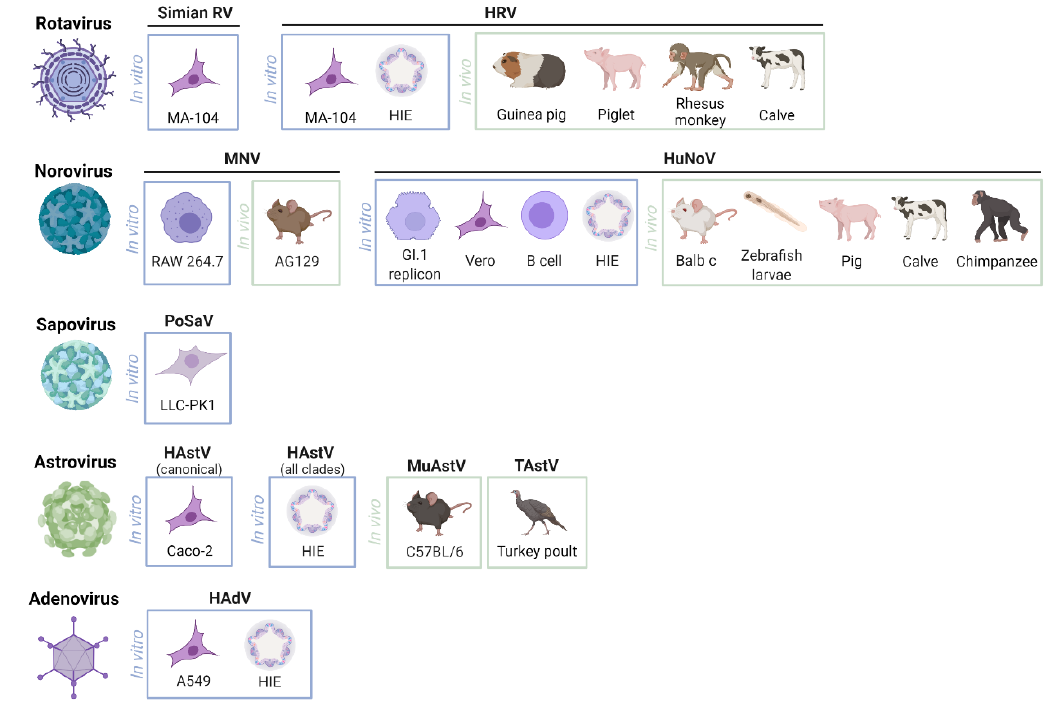
Figure 1. Most described in vitro and in vivo models to study human rotavirus, norovirus, sapovirus, astrovirus and enteric adenovirus, and their surrogates. RV—Rotavirus; HRV—Human rotavirus; HIE—Human intestinal enteroid; MNV—Mouse norovirus; HuNoV—Human norovirus; PoSaV—Porcine sapovirus; HAstV—Human astrovirus; MuAstV—Murine astrovirus; TAstV—Turkey astrovirus; HAdV—Human adenovirus. Created with BioRender.com.